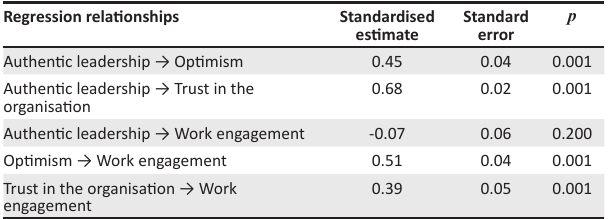
TABLE 3: Regression paths of the research model.